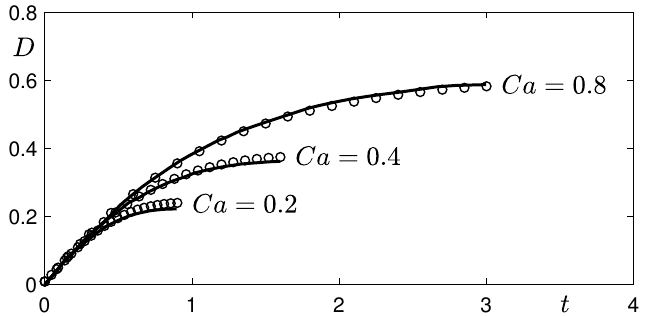
Figure 3. The evolution of the droplet deformation parameter D = ( L − B ) / ( L + B ) . The solid lines and symbols are the results from [32] and the current phase-field method, respectively. Here, Re = 10, Ca = 0.2, 0.4, 0.8 are